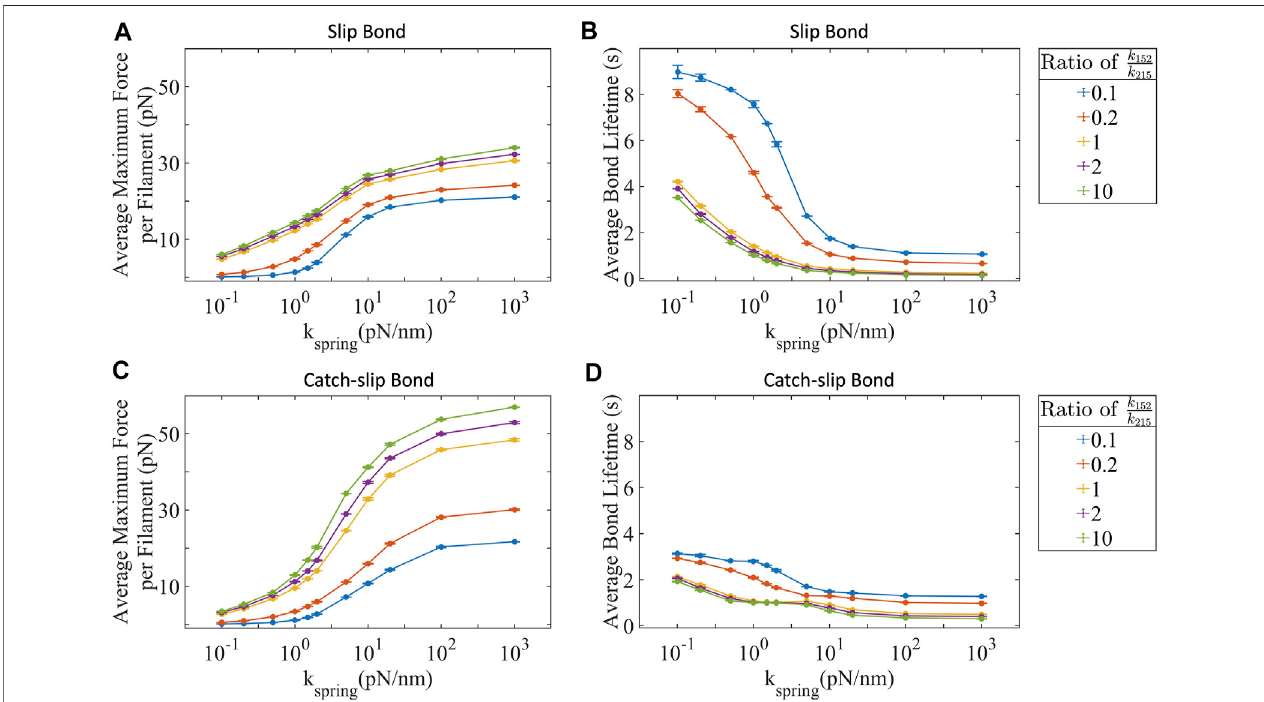
FIGURE 3 | Maximum force transmitted to the substrate is bond type dependent and limited by the bond adhesion lifetime. Both slip bonds and catch-slip bond integrins transmit increasing forces with increased ppMLC2:MLC2 and substrate stiffness with slip bonds (A) transmitting lower forces than (C) catch-slip bonds. Both slip (B) and catch-slip (D) integrins experience decreased bond lifetimes with increased ppMLC2:MLC2 and substrate stiffness. Error bars represent ±SEM for 100 fi laments over three independent